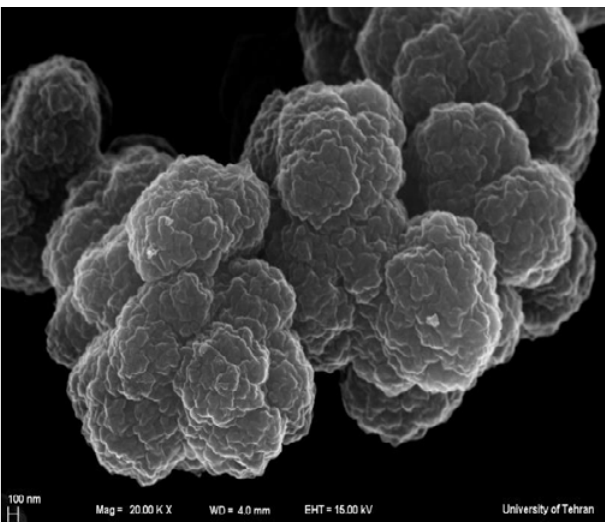
Fig. 9. SEM image for nanocomposite hydrogel containing 4 wt.% montmorillonite nanoclay cloisite 20A.